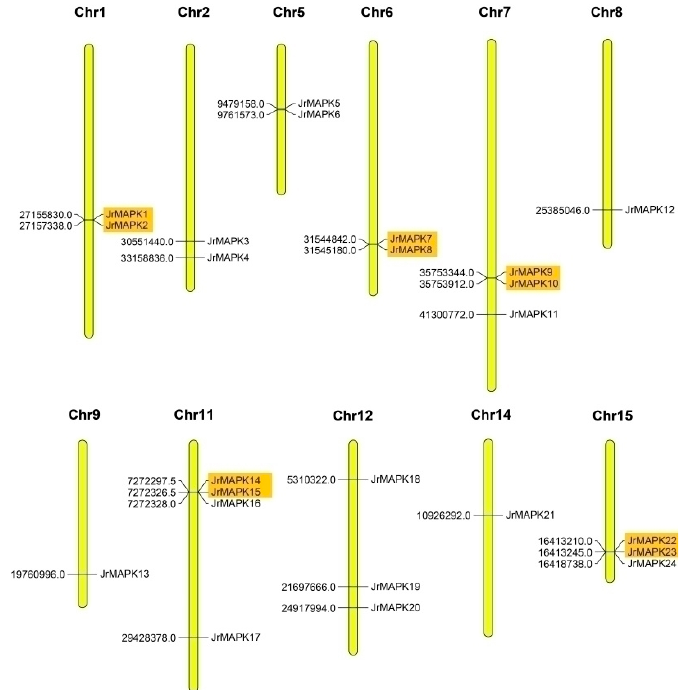
Figure 4. Chromosomal mapping of the JrMAPK genes. The vertical columns represent chromosomes. Chromosome names show on the top of vertical columns. Gene names shown on the right of vertical columns. Gene location shown on the left of vertical columns. Orange boxes indicate tandem duplications.